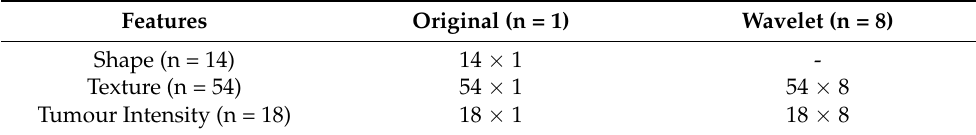
Table 1. Composition of 662 radiomic features extracted using